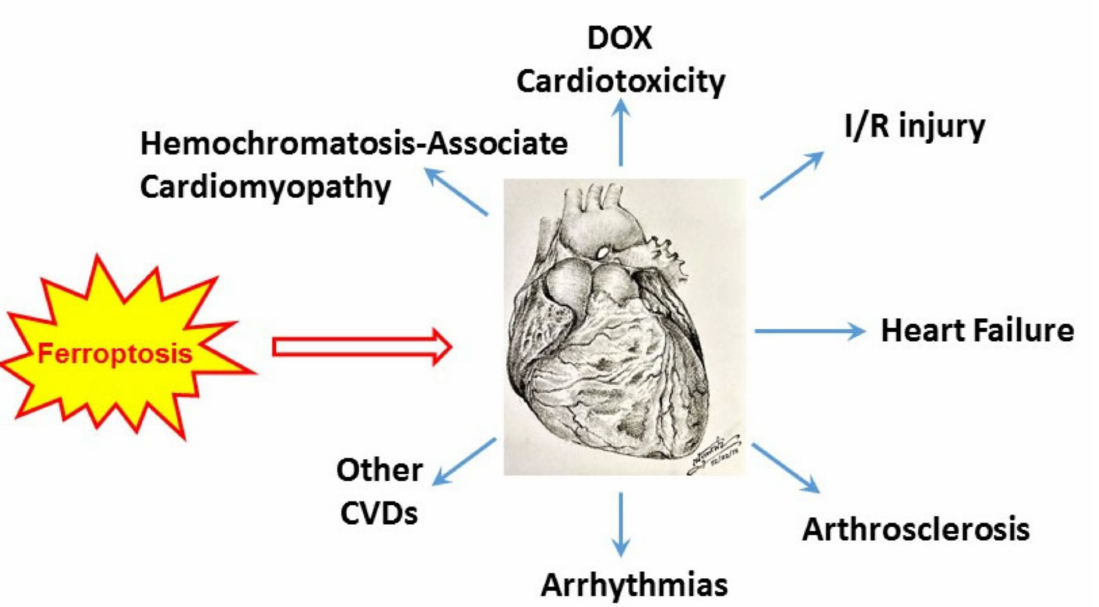
Figure 4. Possible implication of ferroptosis in cardiovascular disease. DOX: doxorubicin; I/R: ischemia-reperfusion; CVD: cardiovascular disease. The sketch of heart was a generous gift from Dr. Natthaphat